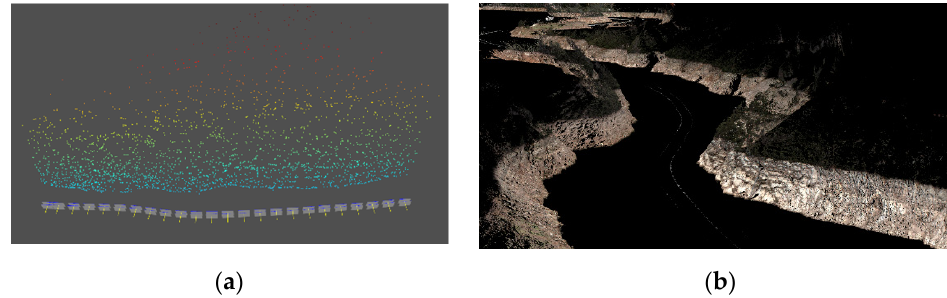
Figure 9. Sparse matching points and the shipborne LiDAR points. ( a ) sparse matching points generated after the BBA; ( b ) shipborne LiDAR points acquired by Pegasus: Two.